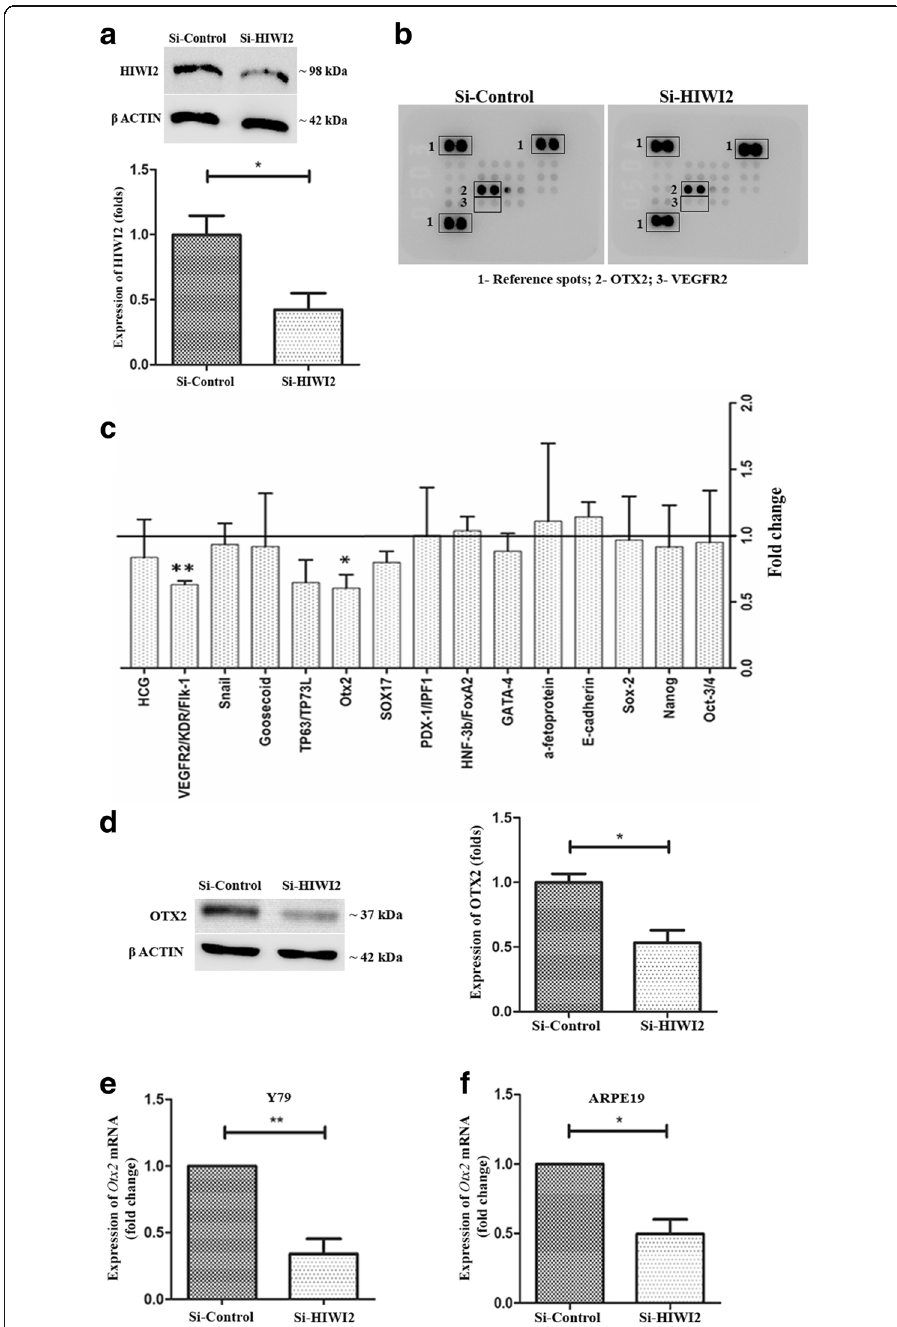
Fig. 2 OTX2 is downregulated upon HIWI2 knockdown. a – Representative western blot image showing HIWI2 expression level in Si-HIWI2 Y79 cells. β -ACTIN was used for normalization and the fold changes are indicated. b – Representative proteome profiler array blot used for screening Si-Control and Si-HIWI2 Y79 protein lysates. c – Fold changes in the expressions of the proteins that are altered in Si-HIWI2 Y79 cells obtained from quantification of the array, are represented in the graph. d – Representative western blot image showing OTX2 expression level in Si-HIWI2 Y79 cells. β -ACTIN was used for normalization and the fold changes are indicated. e – Real-time PCR results indicating the fold changes in the levels of Otx2 transcript in Si-HIWI2 Y79 cells. f – Real-time PCR results showing the reduced expression of Otx2 transcripts in Si-HIWI2 ARPE19 cells. Student ’ s t -test was used for statistical analysis. * p < 0.05 and ** p < 0.01 were considered statistically